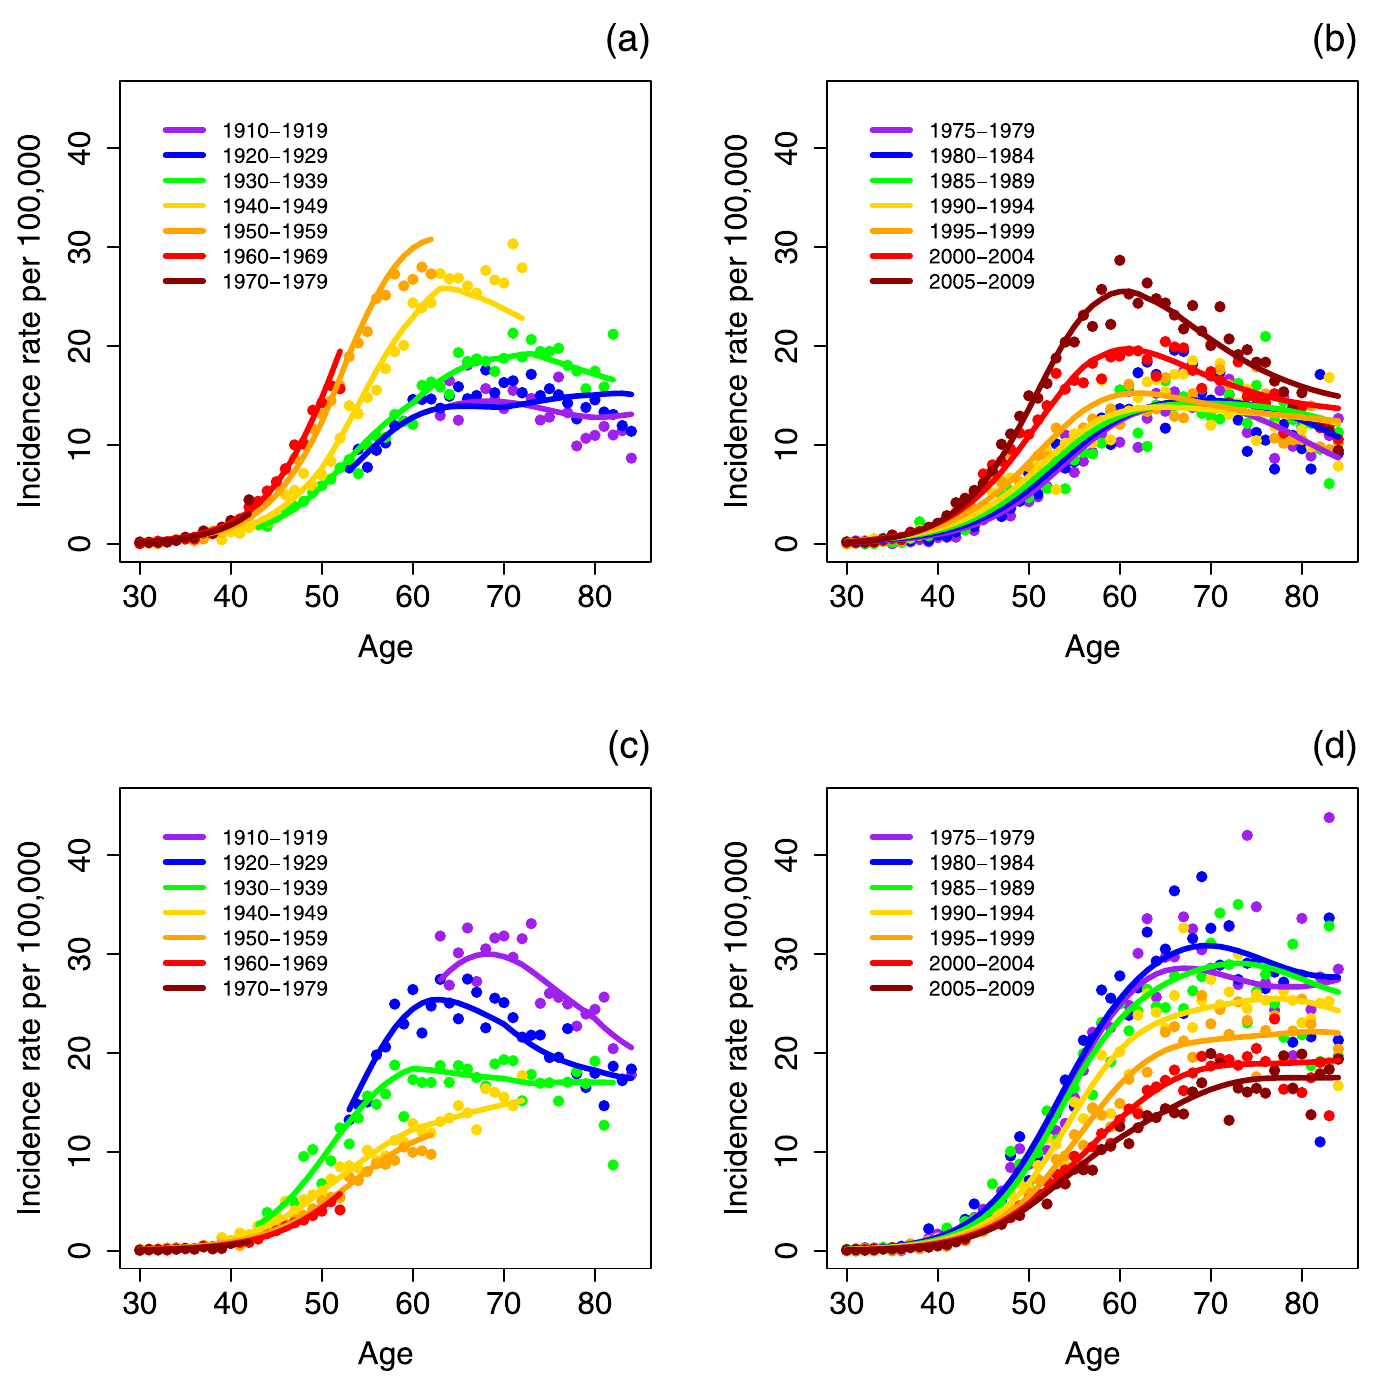
Fig 4. Fits of the two-stage clonal expansion model with period and cohort effects on initiation to incidence rates of oral squamous cell carcinoma among white males for HPV-related subsites, by cohort (a) and period (b), and HPV-unrelated subsites, by cohort (c) and period (d). The dots are SEER data, and lines are model